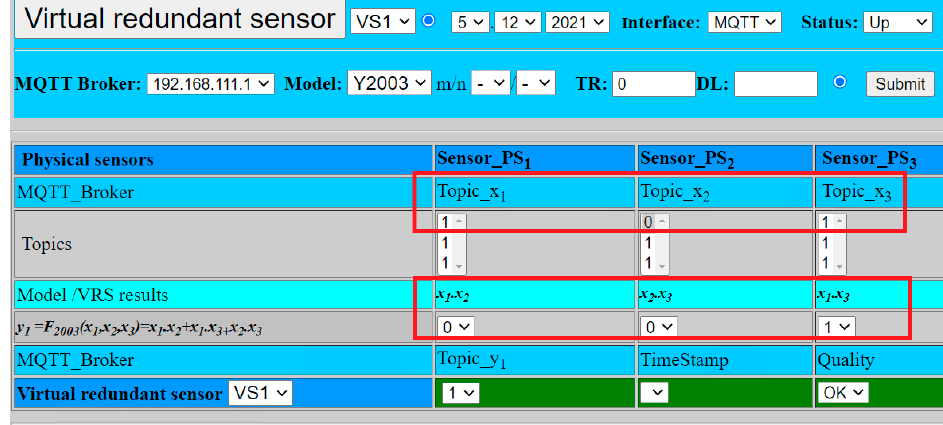
Figure 16. Virtual sensor with digital sensors and fusion function 𝐹 (cid:2870)(cid:2925)(cid:2925)(cid:2871) .